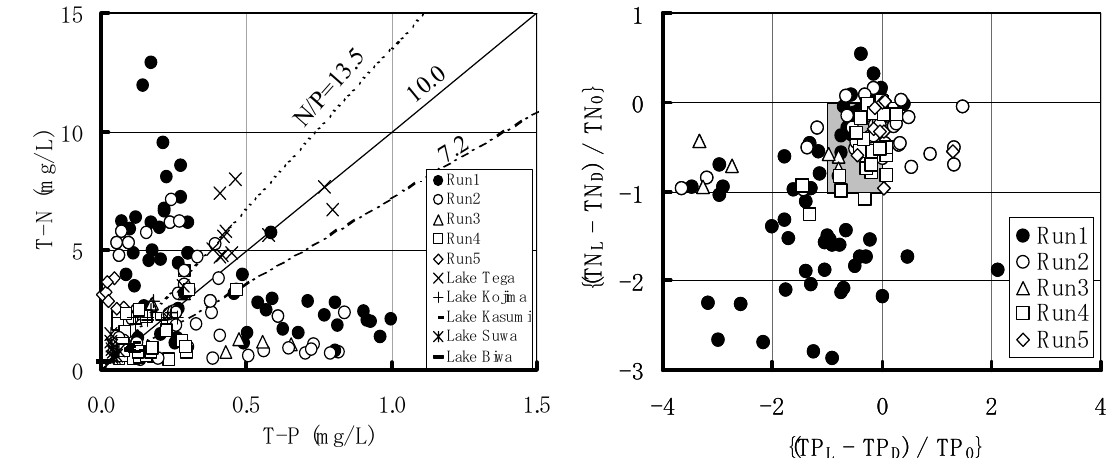
FIGURE 5. Purified concentration due to photosynthetic